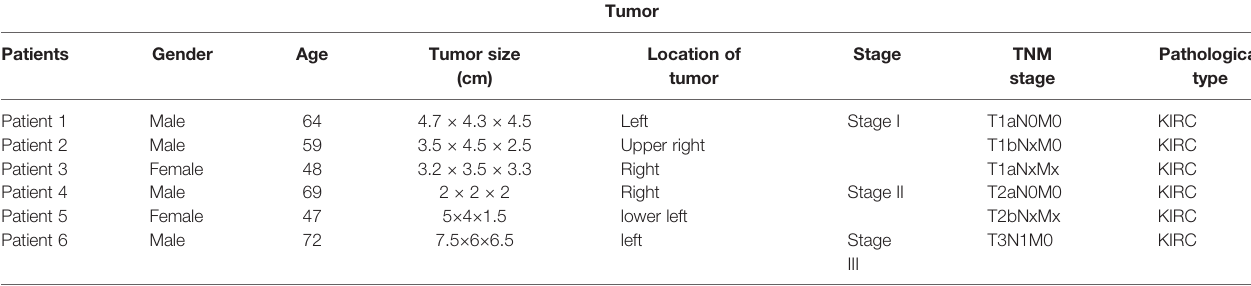
TABLE 2 | General information of clinical